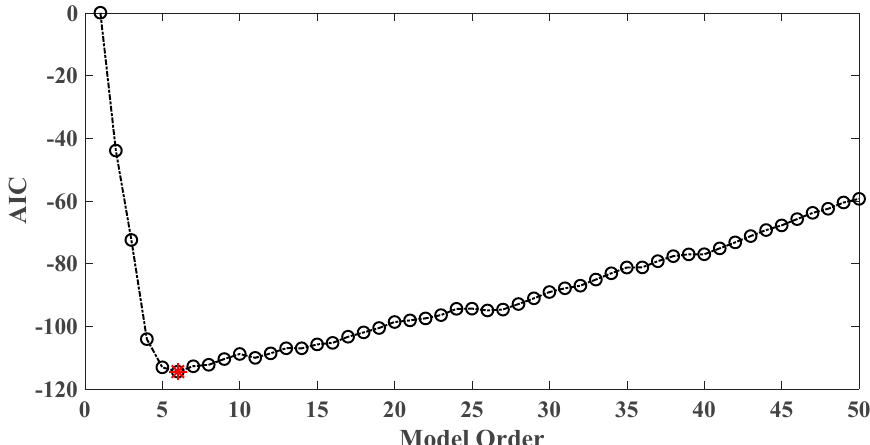
Figure 29. AIC of an AR model for the third floor response under the case of removing braces on the third floor.